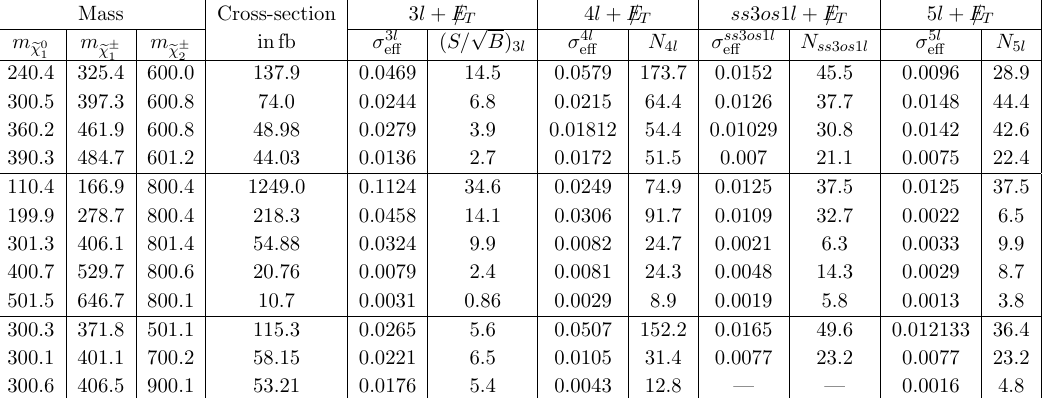
Table 4 . The masses and production cross-sections of all possible eweakino pairs for di(cid:11)erent BPs in the MCLHHS ( f W ) model are given. For the trilepton signal in each case we display the signi(cid:12)cance p ( S= B ). The corresponding (cid:27) e(cid:11) and total number of signal events (with negligible backgrounds) for each type of multilepton signal with n > 3 are also shown. Masses and cross-sections are in GeV and fb